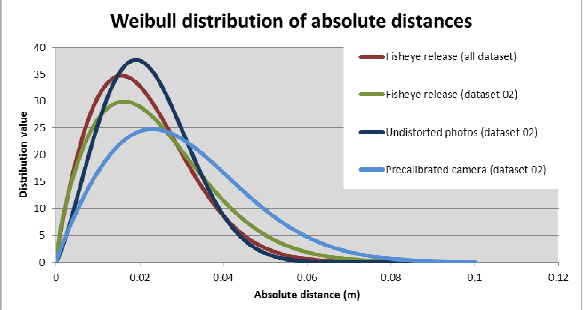
Figure 28: Weibull distribution of absolute distances. Comparison between integrated model and other ones made from dataset